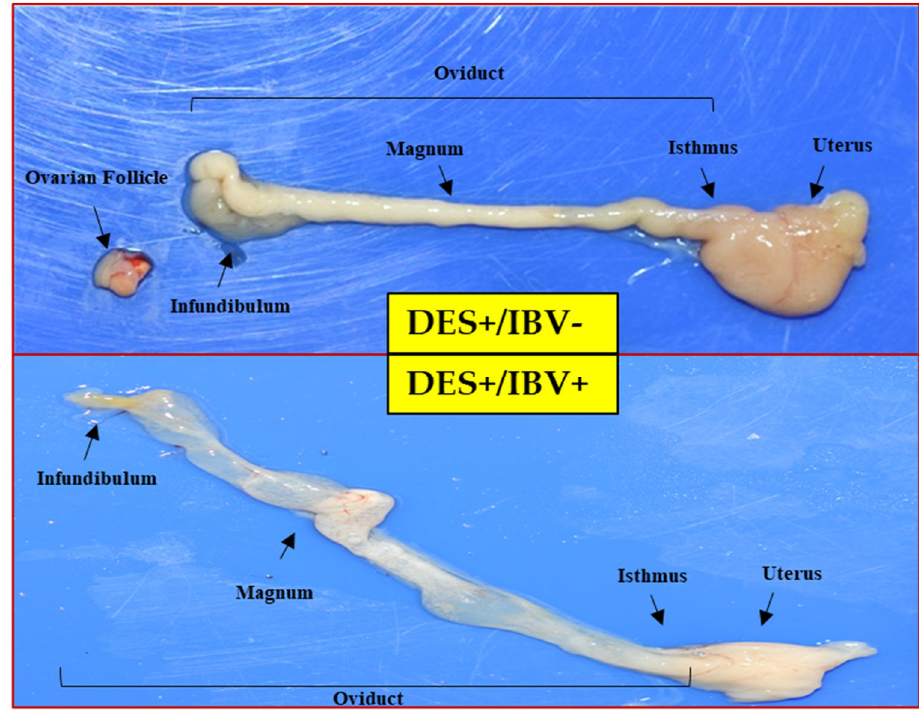
Figure 2. Differences in pathological changes between IBV strains according to sexual precocity after IBV infection. The severe aplasia of the ovarian follicles and atrophy of the oviduct was compared across treated (+) and untreated ( − ) chicks. The yellow arrow indicates a lesion, such as a cyst, in reproductive organs.